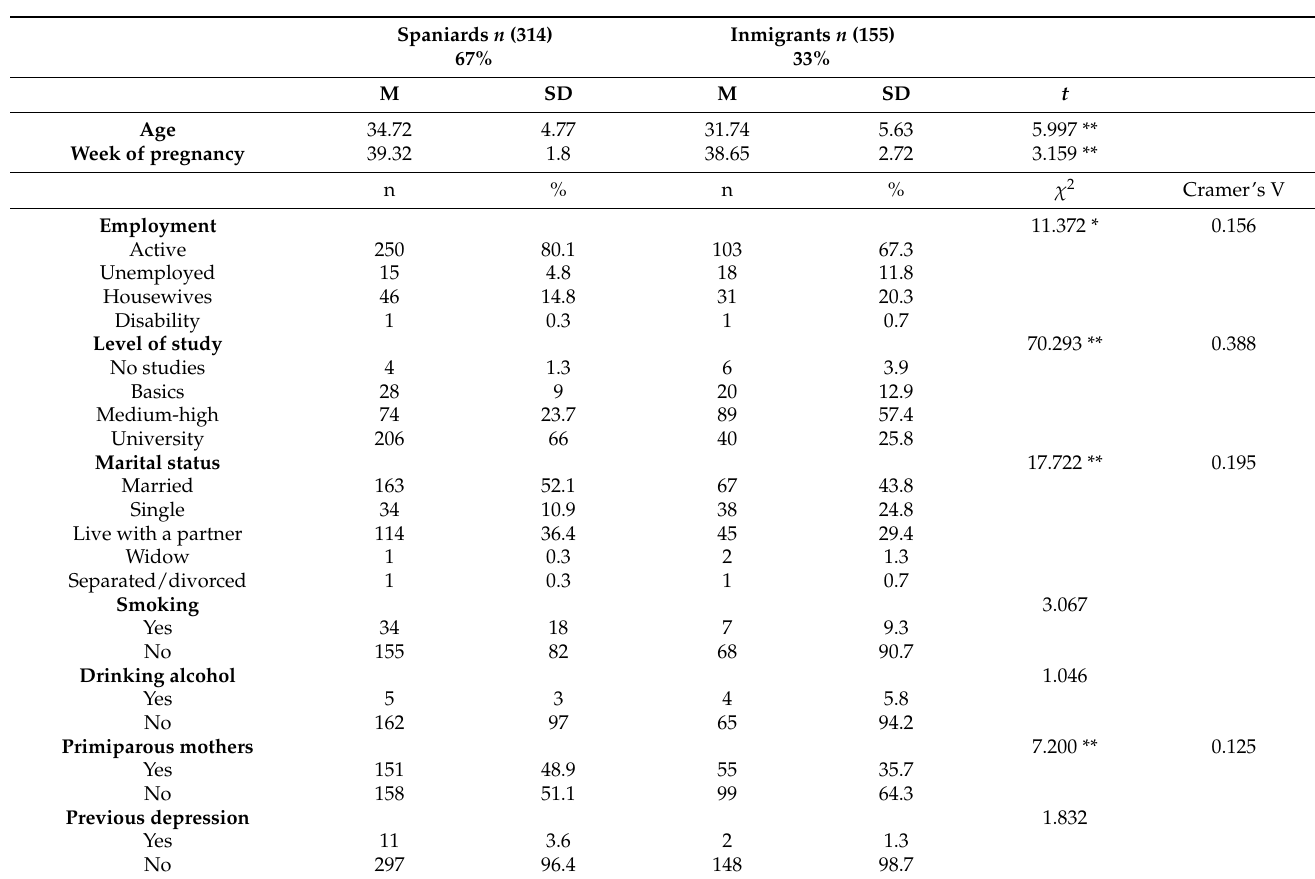
Table 1. Sociodemographic characteristics.